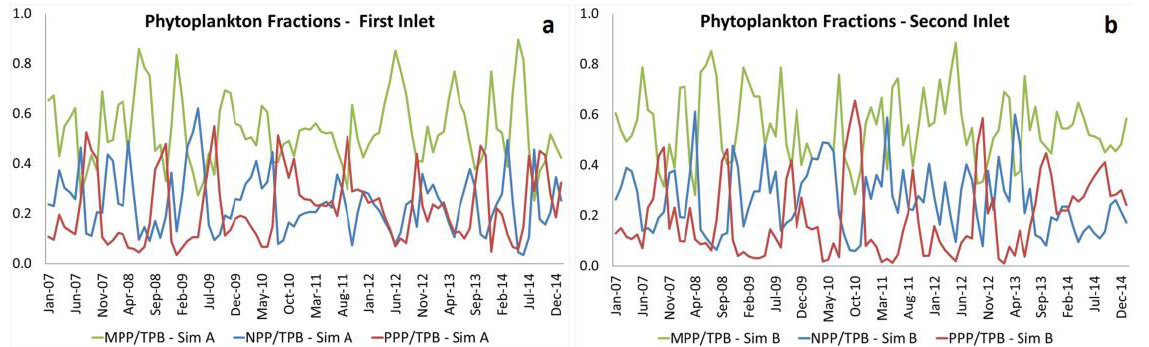
Figure 7. Phytoplankton fractions: Micro-Phytoplankton/Total Phytoplankton Biomass (MPP/TPB) , Nano-Phytoplankton/Total Phytoplankton Biomass (NPP/TPB) and Pico-Phytoplankton/Total Phy- toplankton Biomass (PPP/TPB) ratios in the First Inlet ( a ) and in the Second Inlet ( b ) of Mar Piccolo.